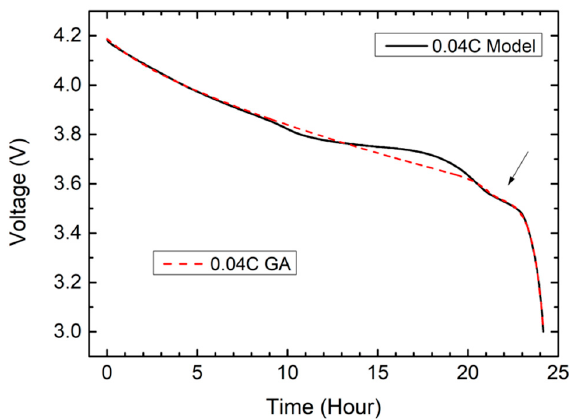
19 of 23 Figure 23. GA results (S brand 18650).